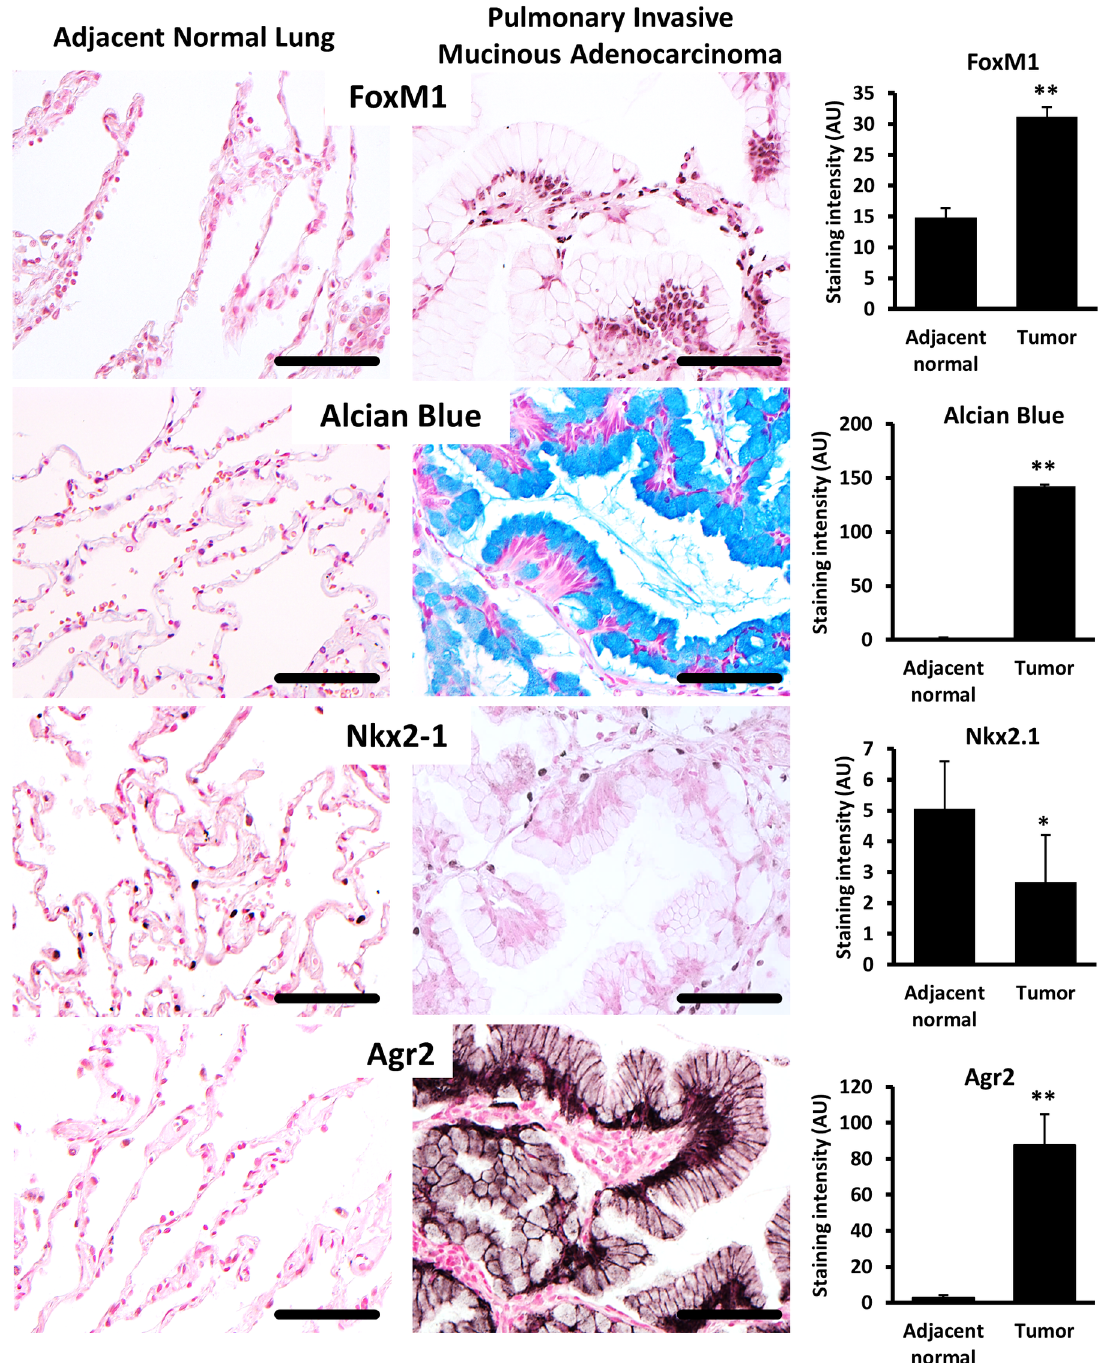
Fig 5. FOXM1 and AGR2 are highly expressedin human pulmonary invasive mucinous adenocarcinomas (PIMAs). Representative images of lungtissue sectionsfrom patients with PIMAs (n = 12 patients, S2 Table). Images includeadjacent normal lung tissue (left panels) and tumor lesions(right panels)in matched patients. Tissue sections were stainedwith antibodiesagainstFOXM1, AGR2, NKX2.1 or stained for mucus using Alcian blue (left panels).Image J software was used to quantify intensity of staining (right graphs). A minimumof 5 random 20x field images per patient were quantified. Increased FOXM1 stainingin PIMAs was associatedwith abundantAlcian blue staining,loss of NKX2.1 and increasedexpressionof AGR2 in tumor